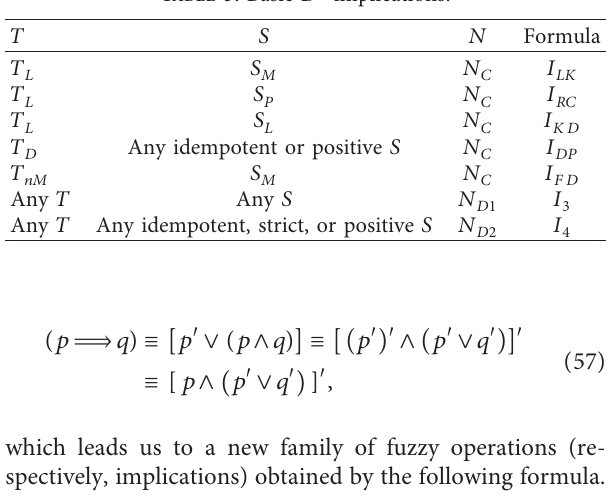
Table 5: Basic D ′